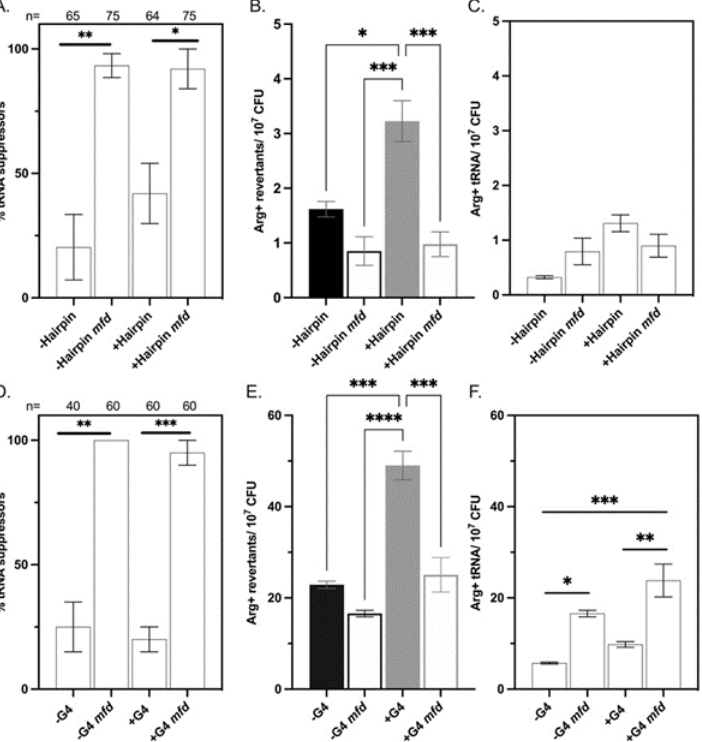
Figure 6. Mfd promotes mutagenesis at argF . ( A – C ) +/ − Hairpin results; ( D – F ) +/ − G4 results. ( A , D ) The proportion of tRNA suppressors from Arg + population sampled that arose from day 5–9. ( B , E ) Arg + mutants that accumulated from day 5–9. ( C , F ) tRNA suppressors that arose in the Arg + population after day 5. Bars represent the mean with SEM. Significance was determined using ANOVA; * denotes p < 0.05, ** denotes p < 0.01, *** denotes p < 0.001, and **** denotes p < 0.0001.